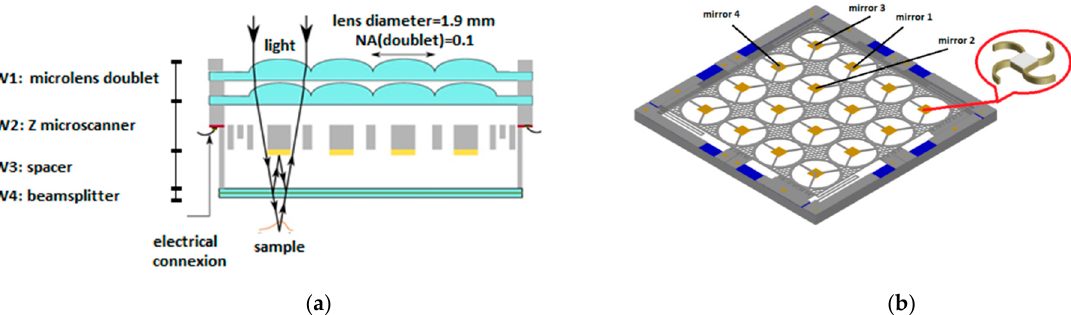
Figure 11. Cross-sectional view of the multichannel ”active” Mirau microinterferometer ( a ) with a focus on a 3D view of an electrostatic vertical microscanner with a 4 × 4 array of suspended reference micromirrors ( b ).